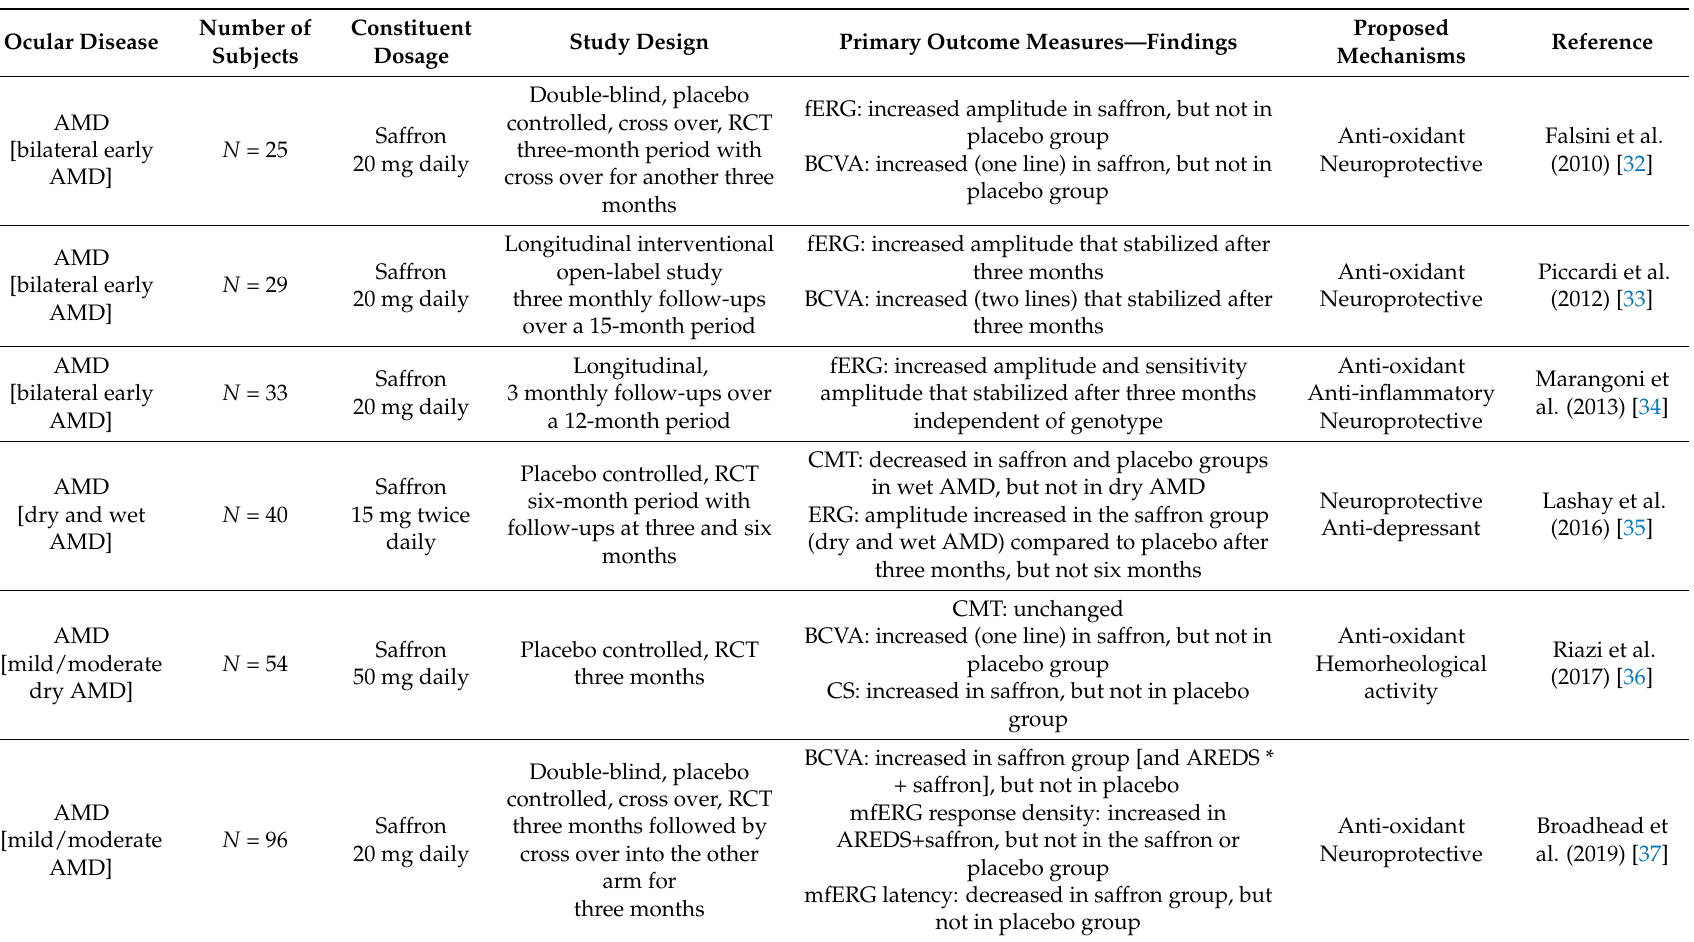
Table 2. Clinical studies investigating the effects of oral supplementation of saffron or crocin on vision-related parameters in adults with ocular diseases. Ocular